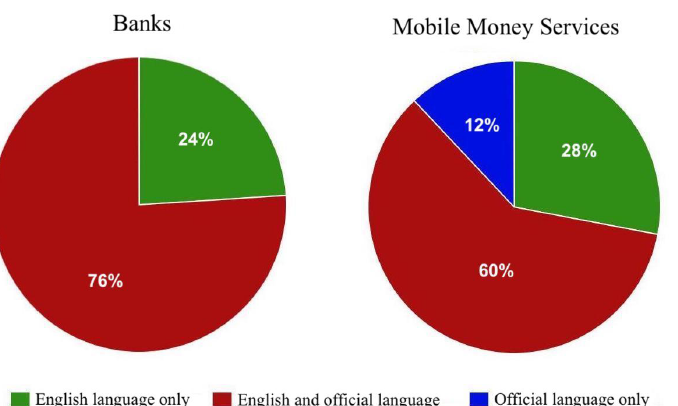
Figure 7. Language distribution of privacy policy for Middle Eastern banks and mobile money